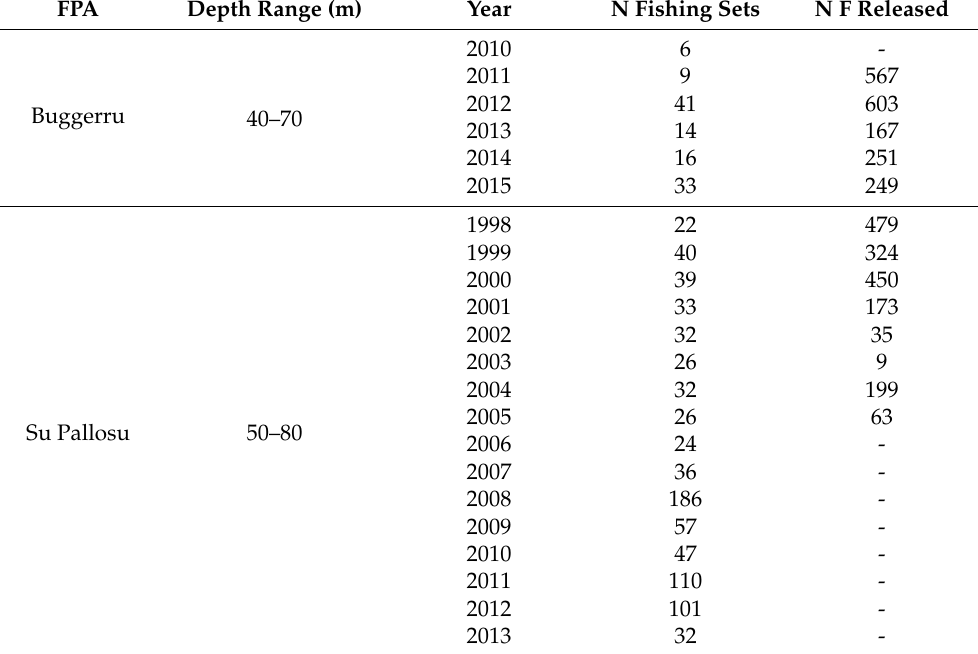
Table 1. Depth range, number of surveys conducted inside and outside of Buggerru FPA by year (2010–2015) and Su Pallosu FPA (1998–2013) and number of released female spiny lobsters/inside of each